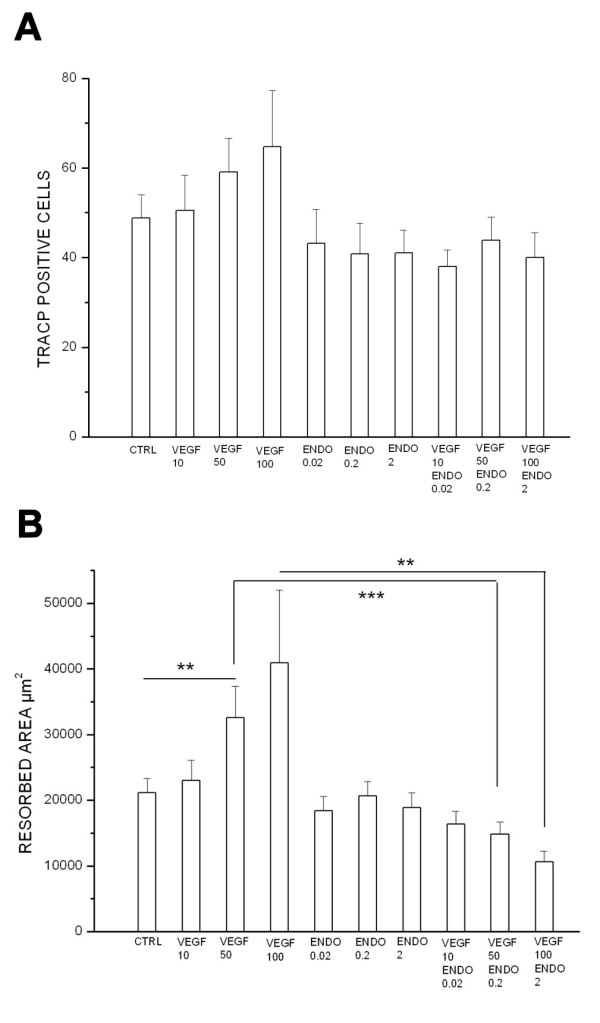
Number of TRACP+ multinuclear cells and the activity of bone resorption in pit assay. Rat bone cells were cultured for 48 hours with no added substances (CONTROL), vascular endothelial growth factor A (VEGF ng/ml), endostatin (ENDO μg/ml) or both VEGF-A and endostatin (VEGF ng/ml +ENDO μg/ml). (A) Survival rate of osteoclasts after different treatments was measured by counting the numbers of TRACP-positive cells with two or more nuclei indicating osteoclasts. No significant differences in the number of osteoclasts could be seen. (B) Osteoclastic bone resorption could be visualized with WGA-lectin stain and total resorbed areas from the different cultures were measured. VEGF-A treatment induced a clear stimulus, whereas endostatin caused no effect on the resorbed area. Addition of both VEGF-A and endostatin caused a statistically significant decrease in the total resorbed area when compared to the VEGF-A-induced resorption. (VEGF ng/ml, ENDO μg/ml)